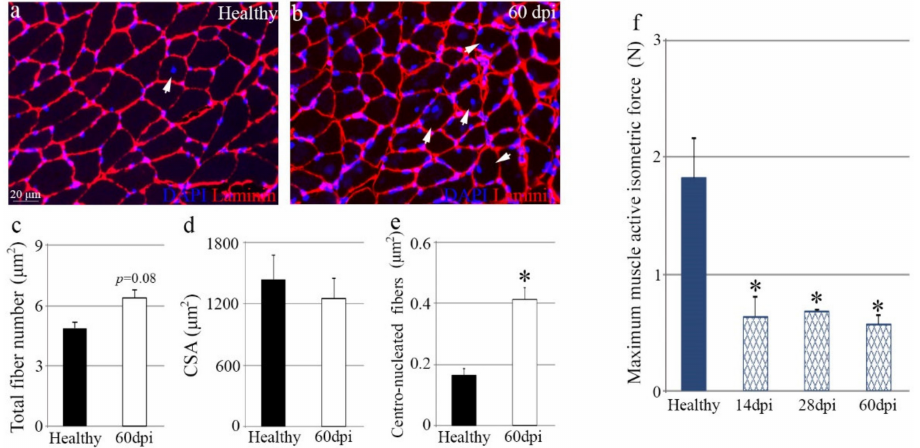
Figure 4. Muscle function declines after chronic tendon rupture. ( a , b ) Representative images of tissue sections of muscles from healthy and injured tendons immunostained for laminin. Arrowheads identify regenerating myofibers with centralized nuclei. DAPI was used to identify all nuclei. Graphs showing the ( c ) total number of fibers in the whole muscle tissue section, ( d ) average CSA and ( e ) the number of myofibers with centralized nuclei of healthy and injured muscles ( n = 4). ( f ) Quantification of muscle isometric force was carried out in six (14 dpi) and four (28 and 60 dpi) biological replicates. Bars represent the mean ± SEM, where * designates significance between muscles from healthy tendons and muscles from injured tendons. dpi, days post-injury; N, Newton.